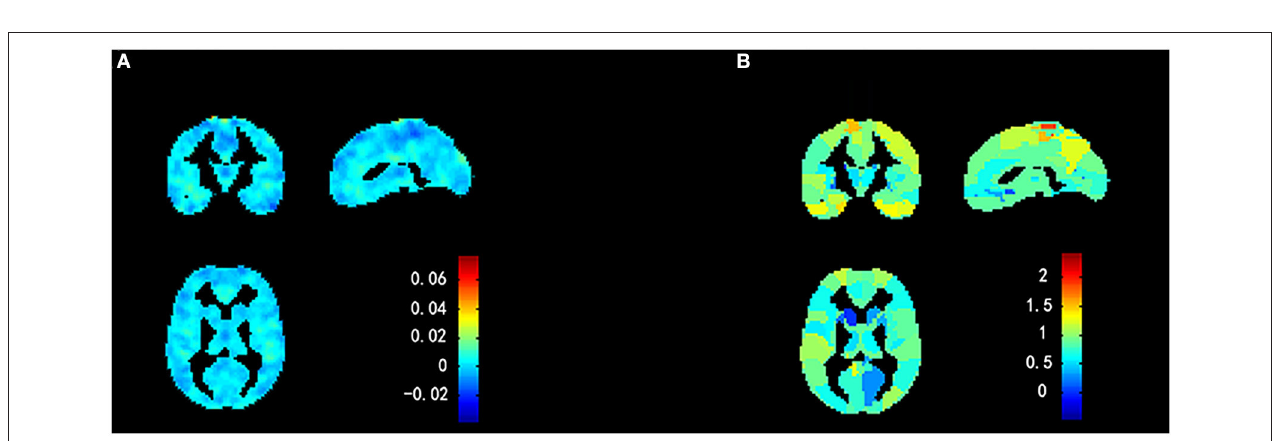
FIGURE 5 | Classification plot (A) and area under receiver operating characteristic curve (B) for non-NPSLE patients vs. controls classification based on DC values (class 1 is patient group and class 2 is control group).